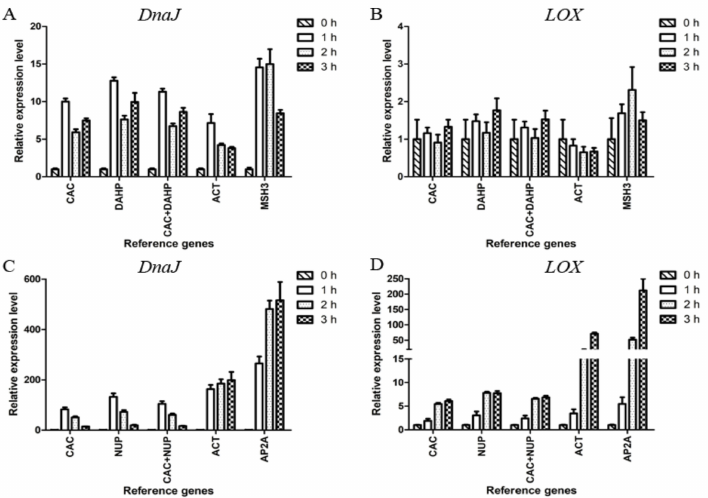
Figure 3. Validation of the selected reference genes. Relative expression of DnaJ and LOX in mycelium ( A , B ) and fruiting body ( C , D ). In mycelium, CAC and DAHP were the most stable candidate reference genes, and MSH3 was the least stable candidate reference gene. In fruiting body, CAC and NUP were the most stable candidate reference genes, and AP2A was the least stable candidate reference gene. ACT , commonly used as endogenous control, was also adopted. Data are shown as mean ± standard deviation (n =